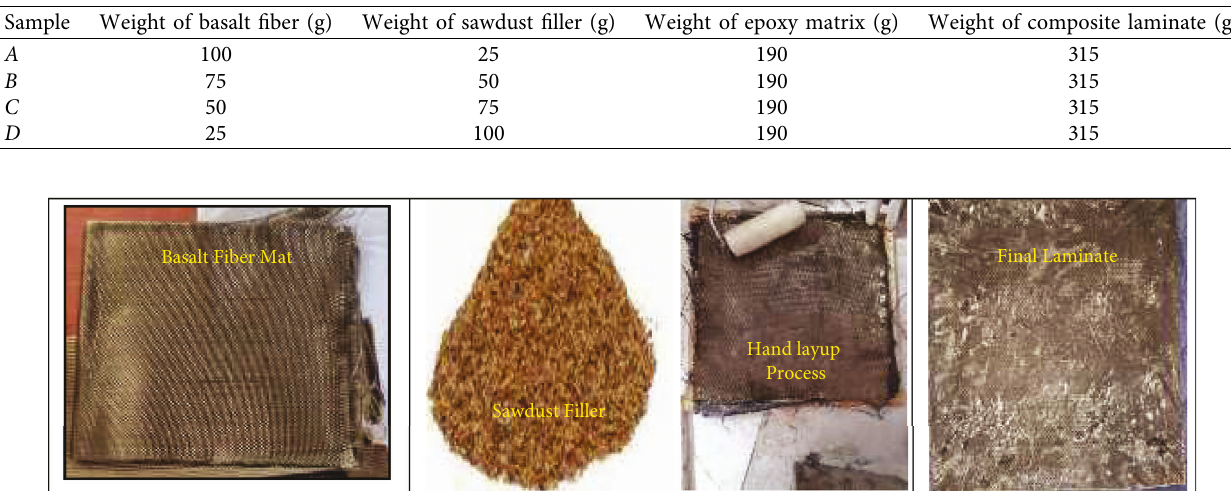
Figure 2: Fabrication process of basalt fiber composite.